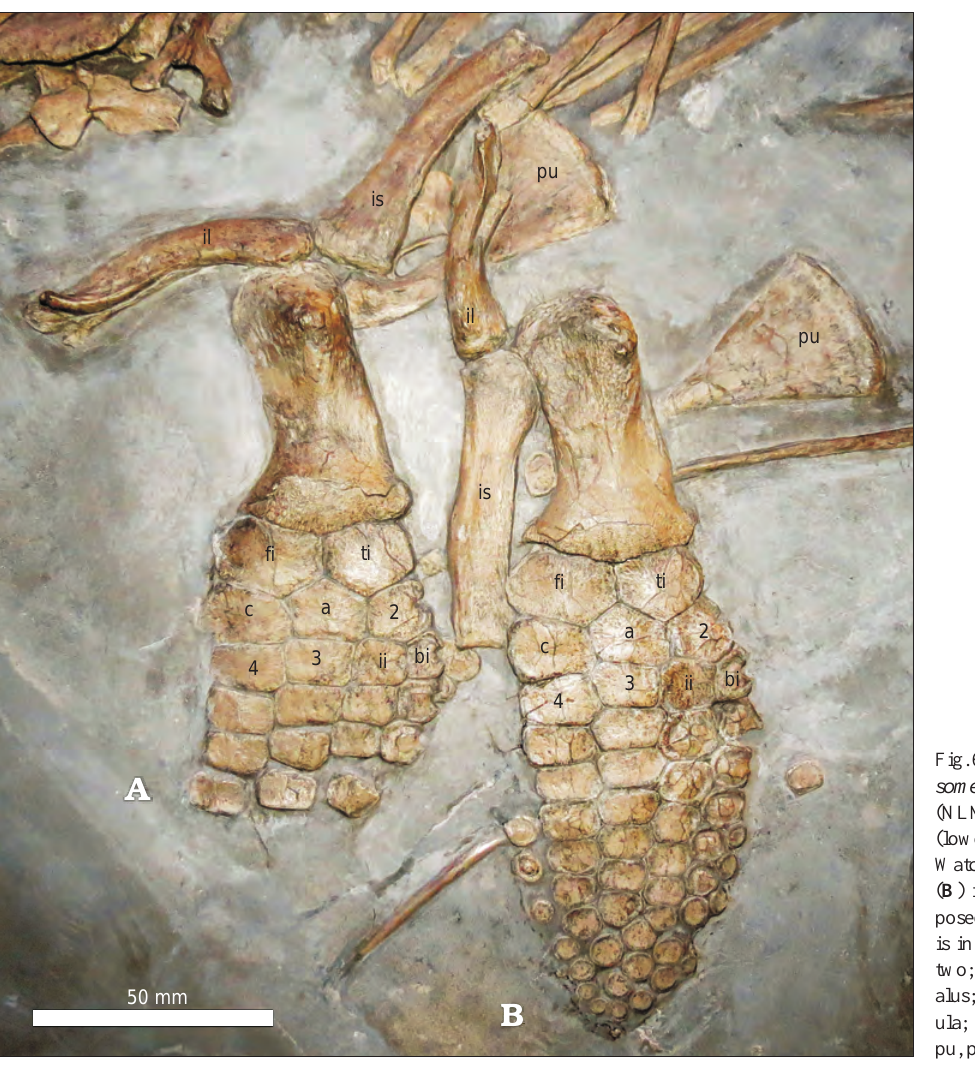
Fig. 6. Hindfins and pelvis of Ichthyosaurus somersetensis Lomax and Massare, 2017 (NLMH 106234) from the Lower Jurassic (lower Hettangian) of Doni ford Bay, Watchet, Somerset, UK. The right hindfin ( B ) is the more complete of the two, ex- posed in dorsal view. The left hindfin ( A ) is in ventral view. Abbreviations: 2, tarsal two; 3, tarsal three; 4, tarsal four; a, astrag- alus; bi, bifurcation; c, calcaneum; fi, fib- ula; ii, metatarsal 2; il, ilium; is, ischium; pu, pubis; ti,